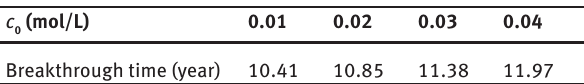
Table 2: Breakthrough time of pollutant under different initial pollutant